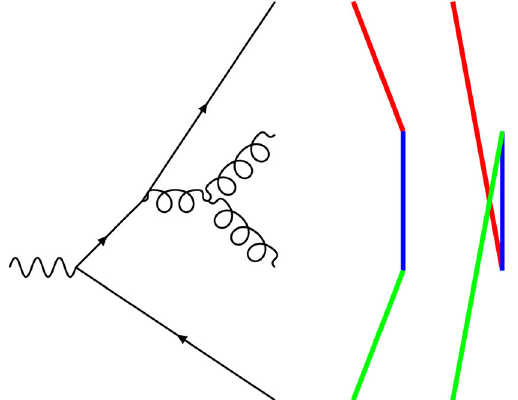
Fig. 1 Simple process with three colour dipoles. This process is used to calculate the weight for the colour